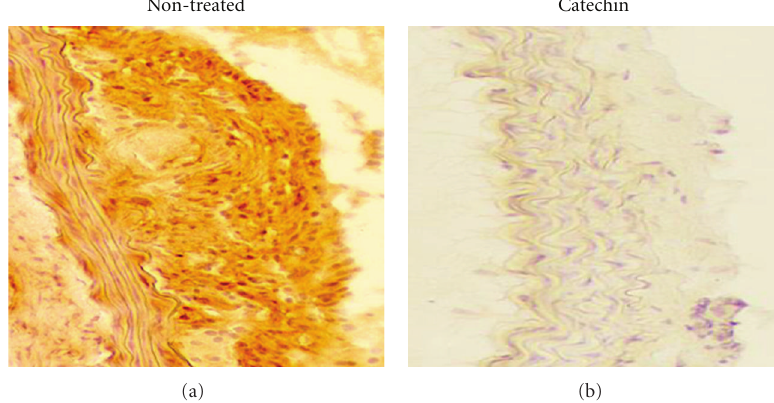
Figure 4: Immunohistochemistry of atherosclerosis. Panels show representative immunohistochemical findings. VCAM-1 expression was enhanced in the aortic walls of non-treated LDLRKO mice. However, catechin administration (2% THEA-FLAN 90S contained high fat chaw) suppressed the expression in the organs of LDLRKO